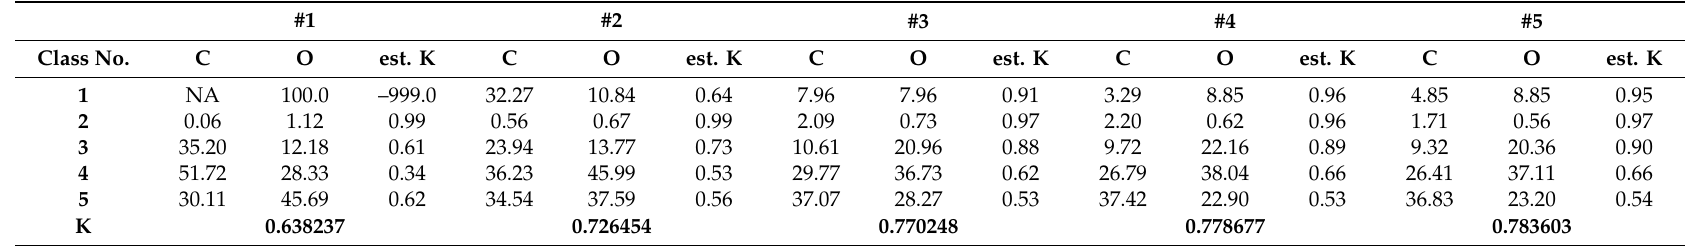
Table 8. The accuracy assessment of the random forest algorithm for the Varaždin study area.